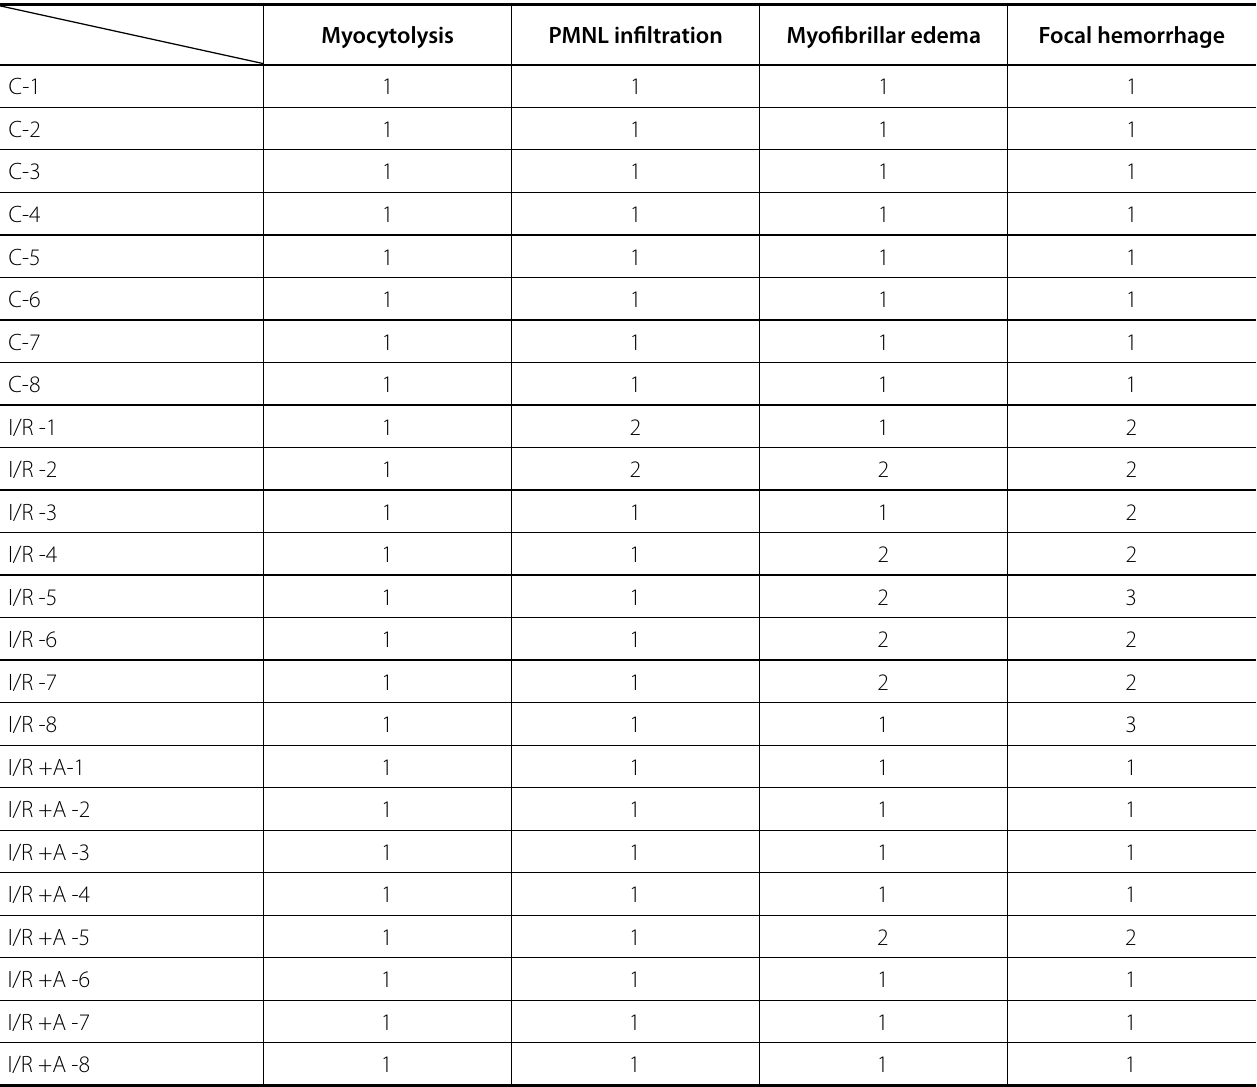
Table 1. The histopathological results of all test groups and the control group.